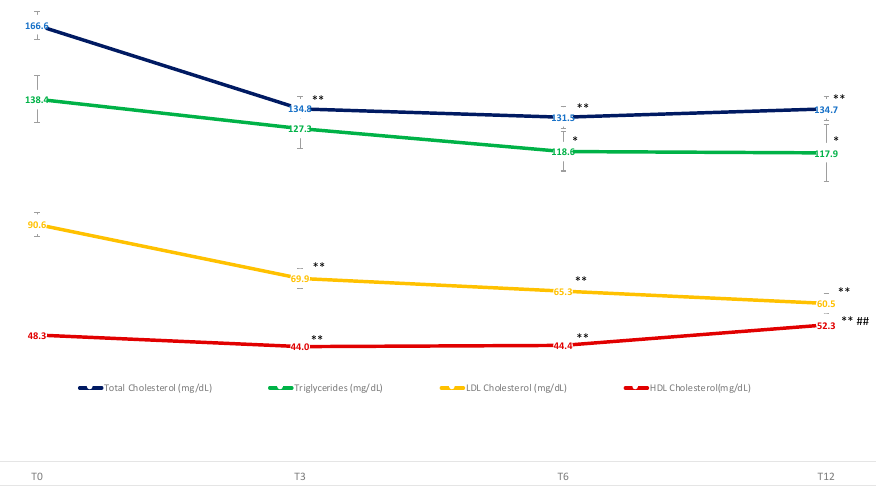
Figure 5. Mean changes in serum values of Total Cholesterol, Low-Density Lipoprotein (LDL) Cholesterol, High-Density Lipoprotein (HDL) Cholesterol, and Triglycerides (mg/dL) through the study period. Means are reported as Least Squared Means estimated by Mixed Model analysis. Variation versus T0: * p < 0.05; ** p < 0.01. Variation versus previous time: ## p < 0.01.